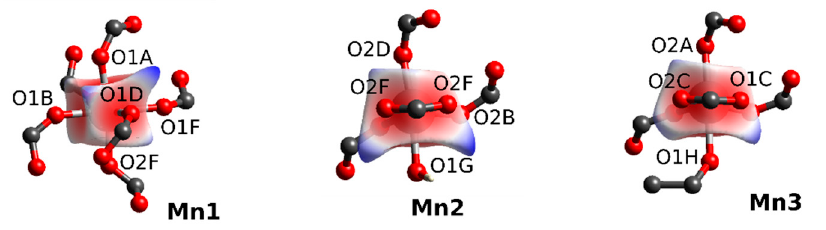
Figure 2. The Hirshfeld Surface of Mn 2+ centers in 1 with a normalized contact distance (d norm ) mapped on it. The parameter d norm ranges from –0.76 to 0.76.